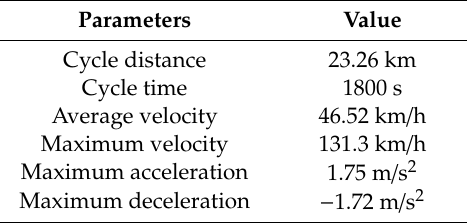
Table 3. WLTP velocity profile configurations.